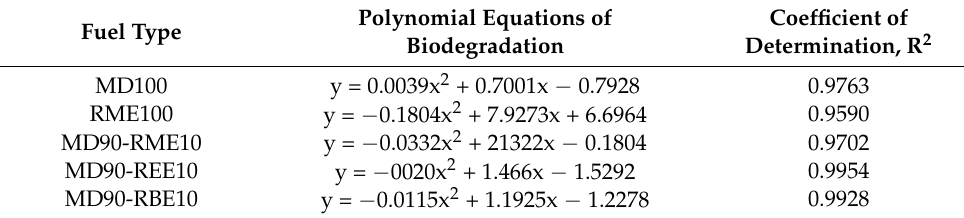
Table 3. Dependence of the biodegradation of fuels and their mixtures in aqueous media on storage time. Fuel